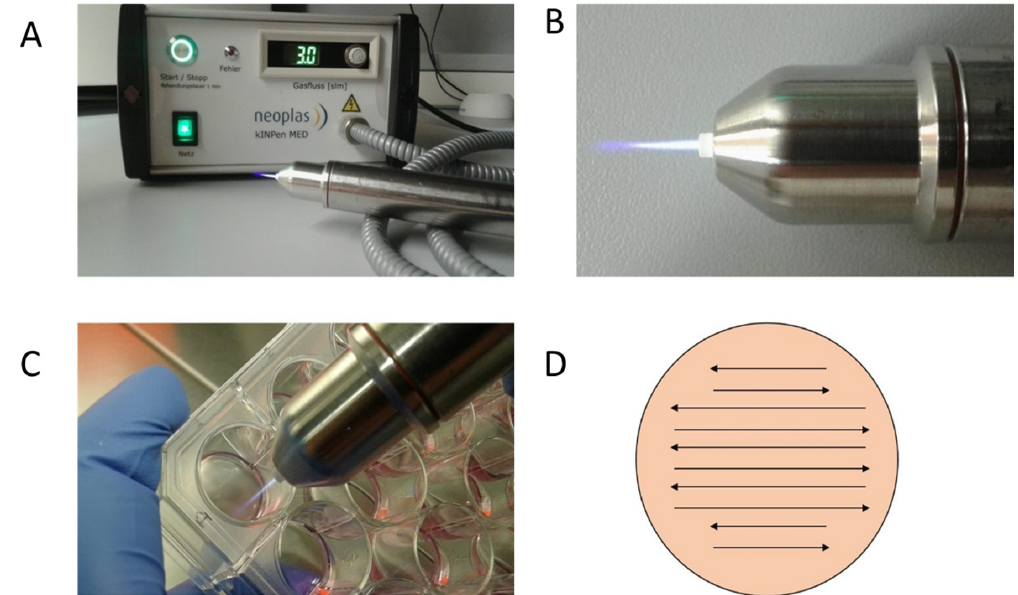
Figure 6. Plasma Jet kINPen MED (neoplas tools, Greifswald, Germany): detailed photos of the device